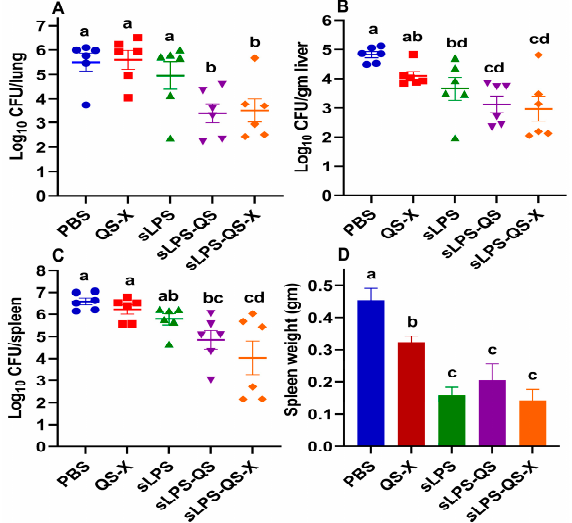
Figure 5. Impact of vaccine formulations on bioburdens of different organs and spleen weights one-month postchallenge. Data represent the calculated average Log ± SE, CFU of B. abortus S-19 recovered per lung ( A ), gram of liver ( B ), or spleen ( C ). ( D ) Spleen weights of mice. Animals challenged 4 weeks after the boost. B. abortus S19 was used at 1.92 × 10 7 CFUs/mouse. Data were analyzed by ANOVA and Least Significant Difference (LSD) was used to determine differences between the groups. Different letters indicate that values are significantly different. A p -value of less than 0.05 was considered statistically